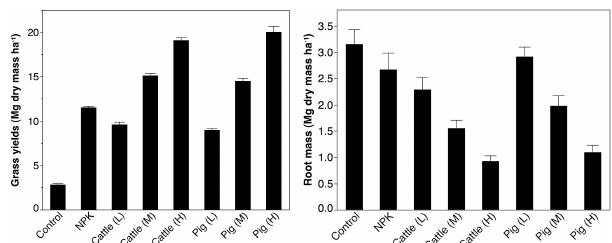
Figure 6. Overall GHG emissions (in CO 2-eq ) based on different nutrient treatments (a) and percentage of GHG emissions that can be offset by soil C sequestration associated with long-term inor- ganic and organic nutrient additions. Estimates refer to dairy and beef farming systems and are calculated as net contribution of mul- tiple GHGs (i.e. global warming potential; see Supplement). Ab- breviations as in Fig. 1. Standard errors indicate variation among six replicate values for each